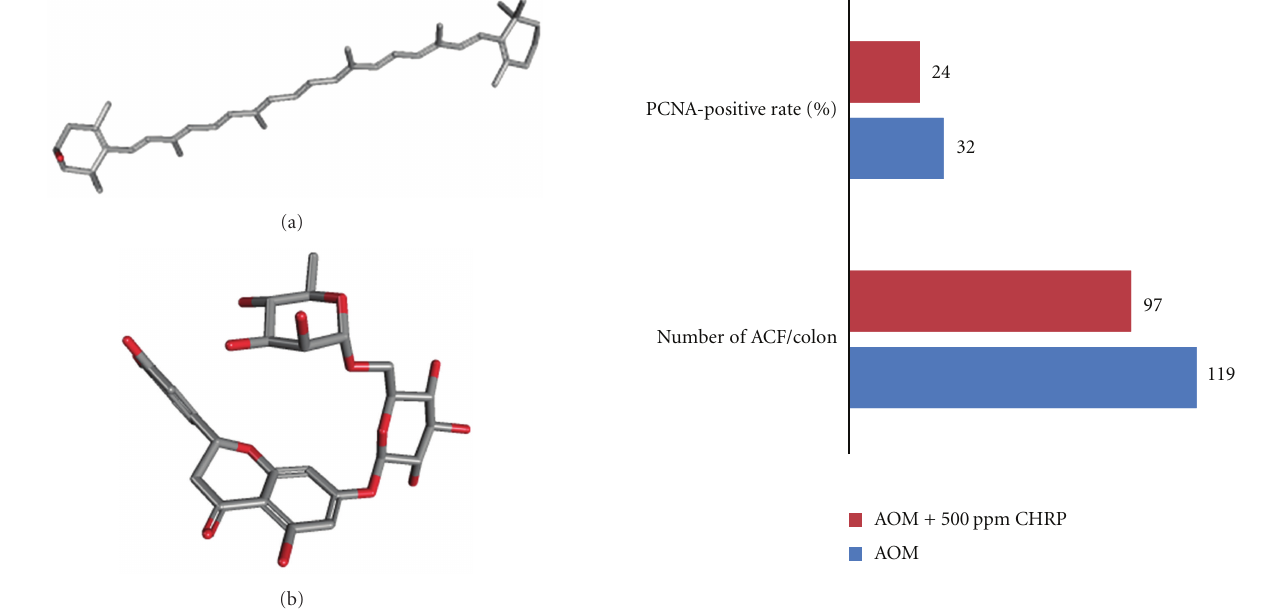
Figure 1: 3D chemical structures of (a) β -cryptoxanthin and (b) hesperidin.